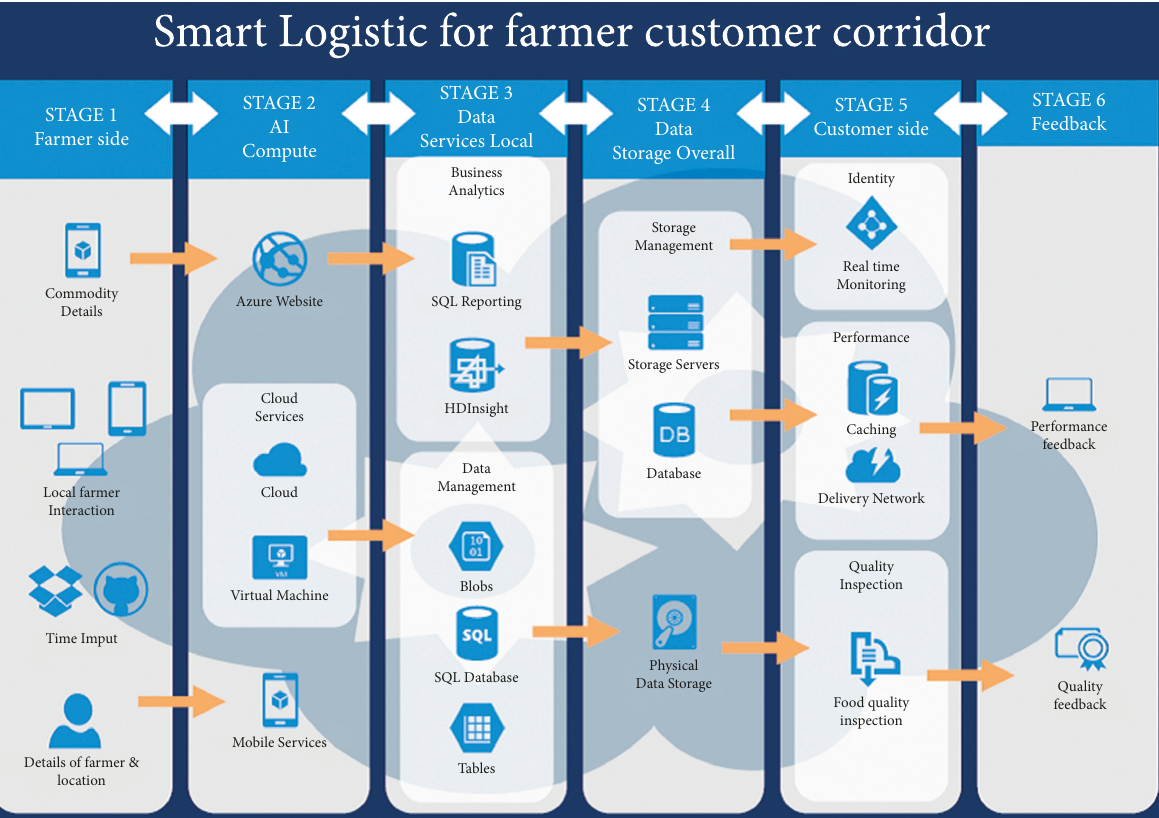
Figure 3: AI-based smart logistic architecture for farmer-customer